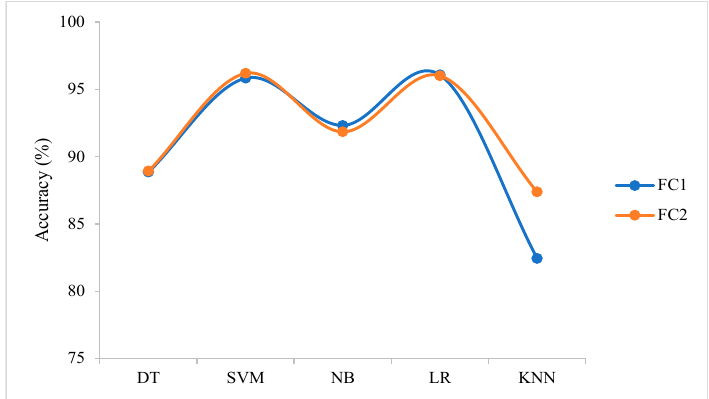
Figure 6. Comparison of transferable features and classifier performance.